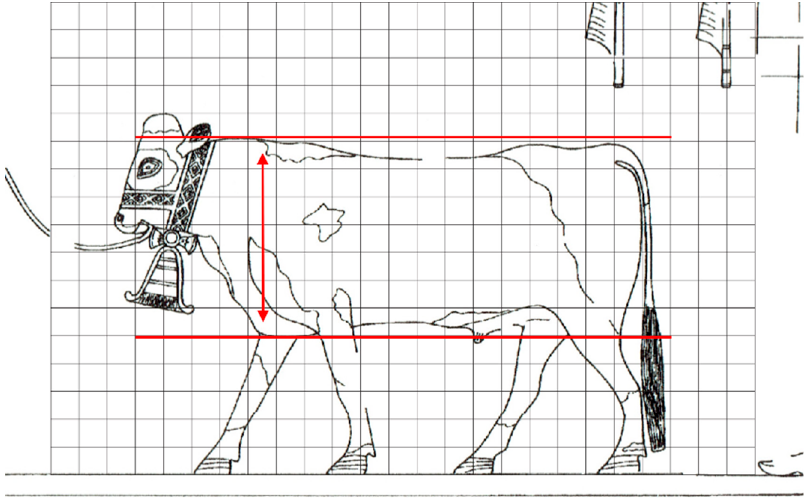
Figure 4. An ox from the tomb of Amenemhat (Tomb 2) with the hypothetical Meir grid applied Table 2016. pl. 108) with a grid system applied by the author.